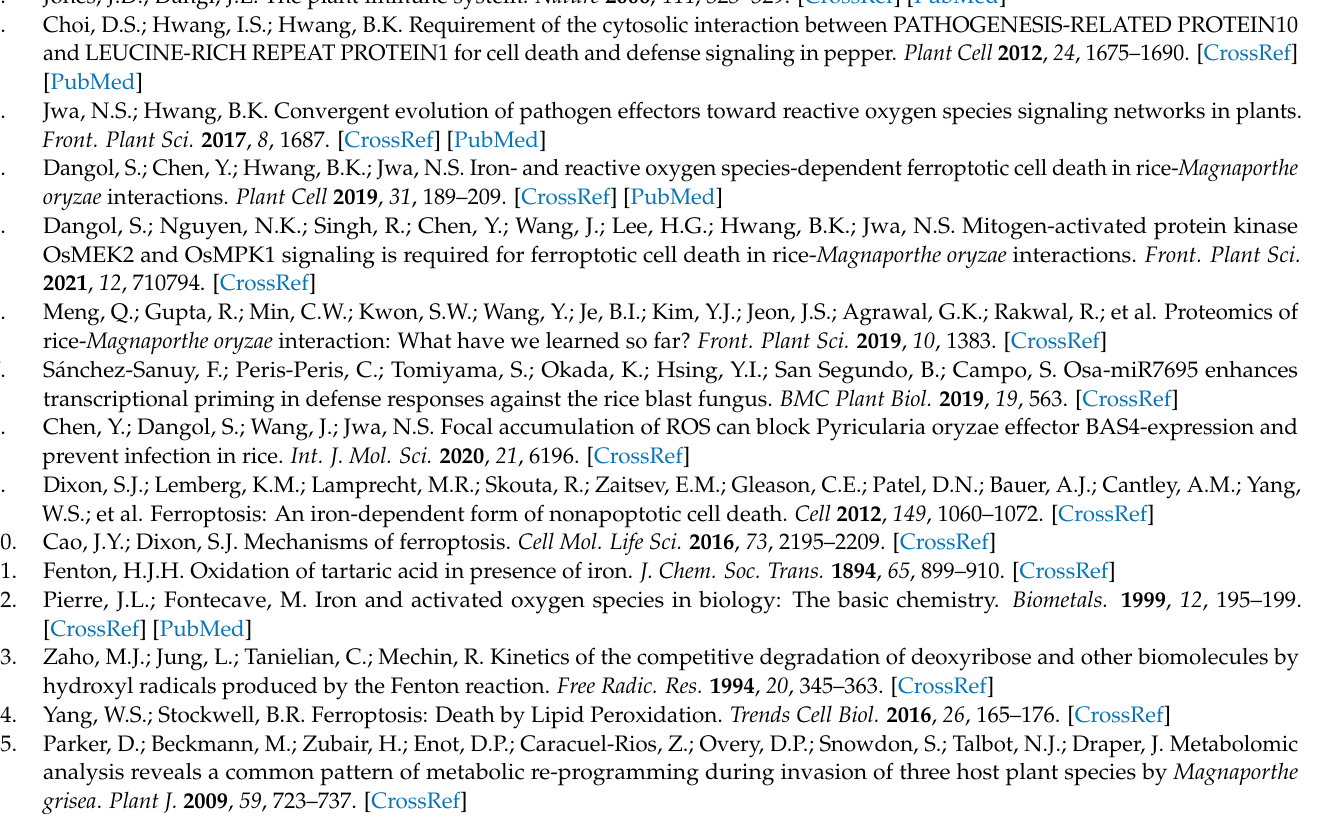
Table S2: Accession numbers of RWP-PK proteins used in this